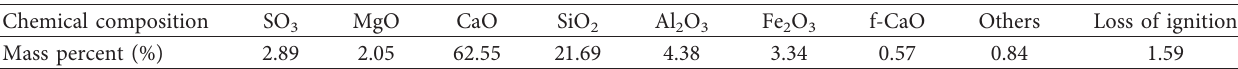
Table 2: The chemical composition of